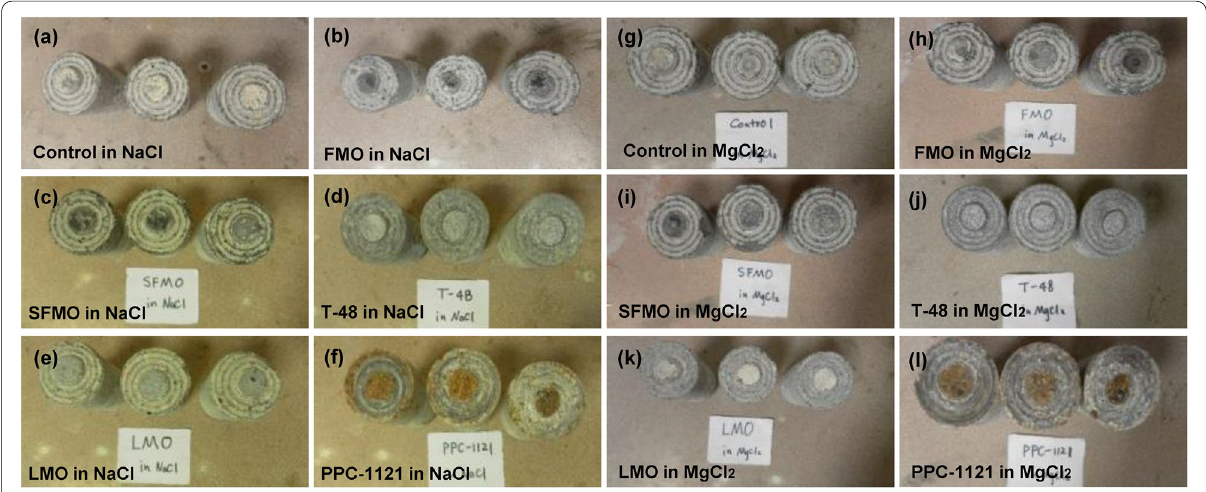
Fig. 5 The image of various concrete-substrate-overlay composites after